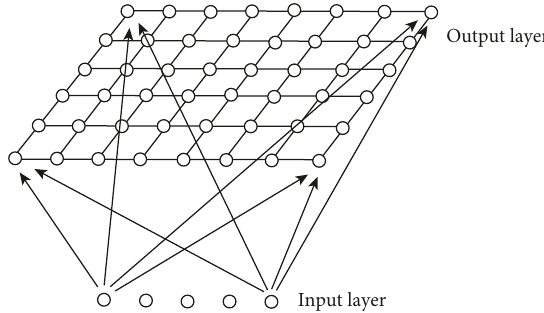
Figure 1: The spatial structure of neural